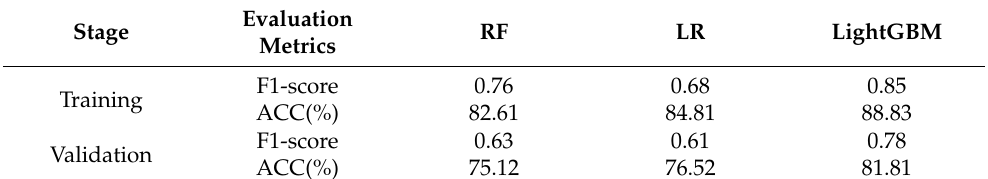
Table 3. Performance of the three models.